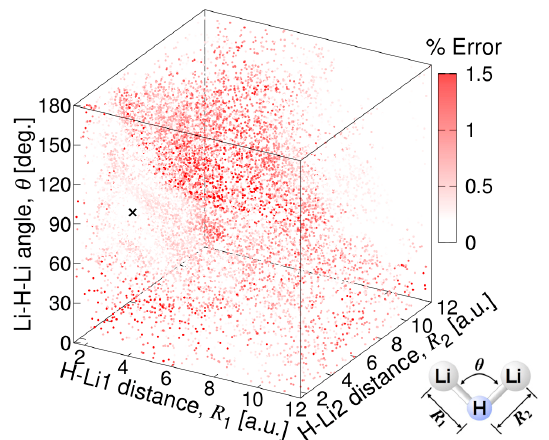
Figure 3. Fitting error distribution of the global analytical PES of Li 2 H in the coordinate space ( × : equilibrium geometry).